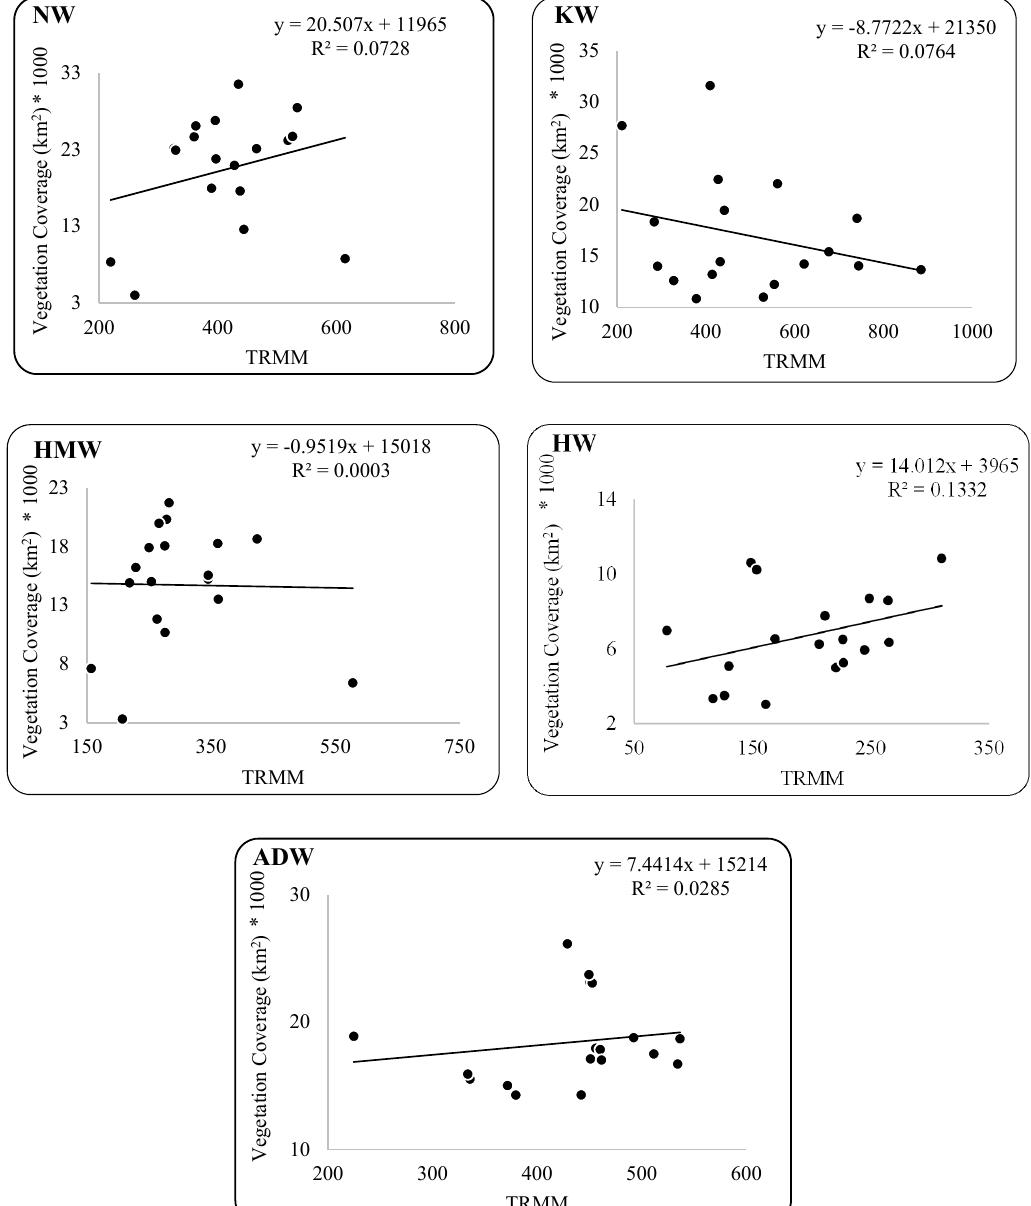
Figure 10. Scatter plot of time series of precipitation and vegetation coverage of each watershed in Afghanistan between 2001 and 2018.